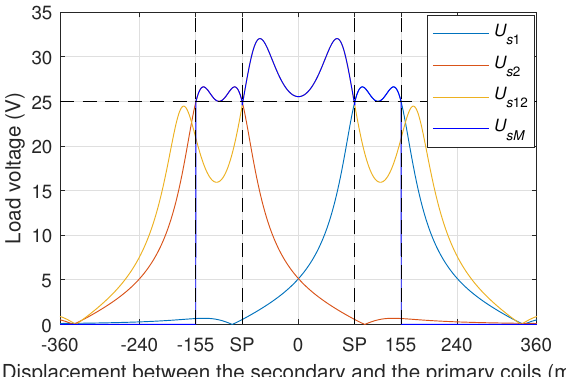
Figure 7. Load voltage simulation diagram of primary coils in adaptive working